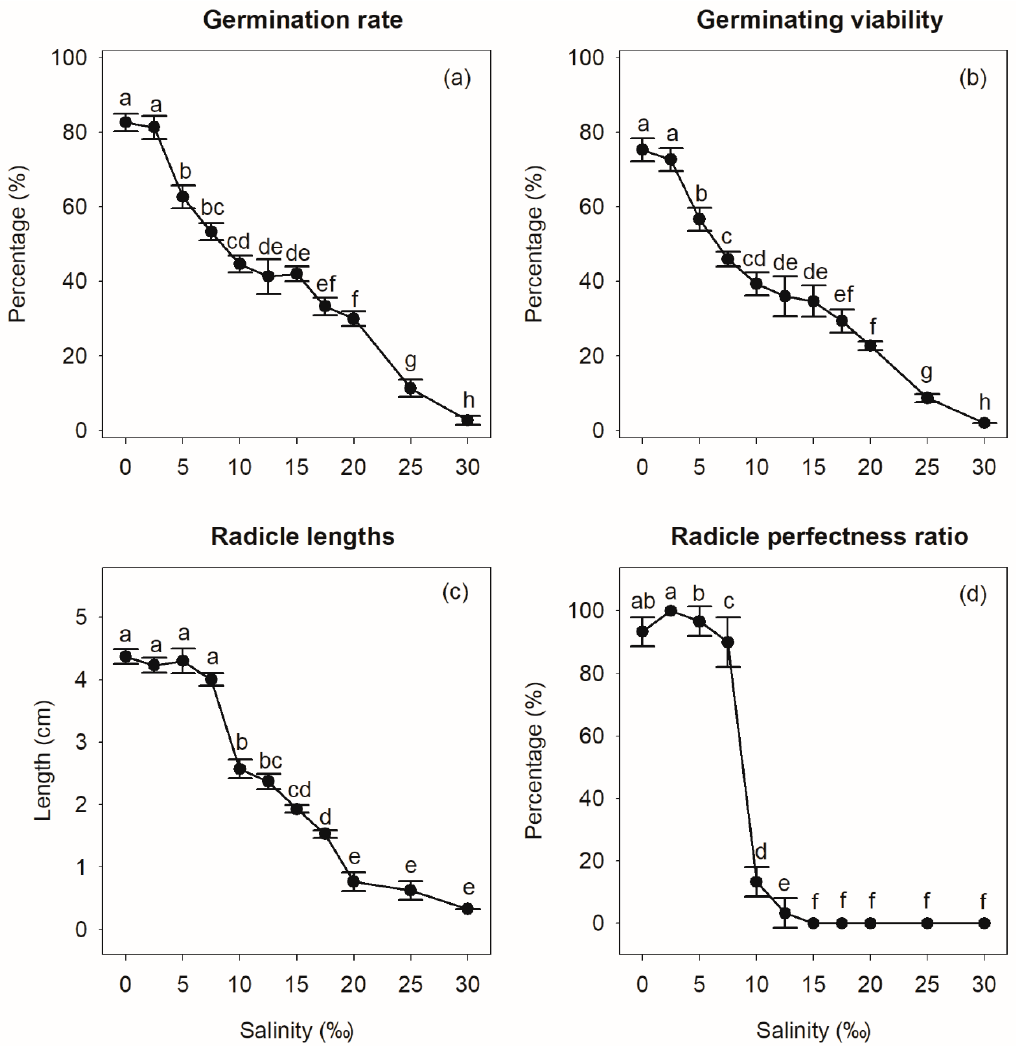
Figure 5. Effects of different salinities on indicators. Different letters indicate significant difference ( p < 0.05).